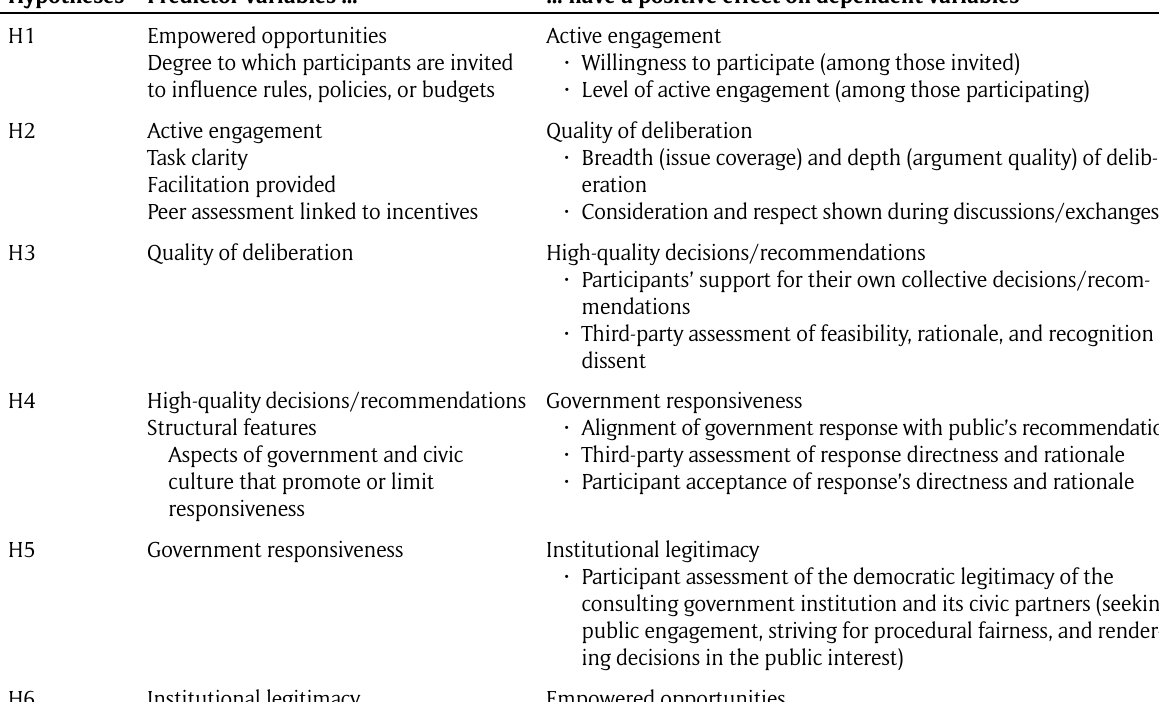
Table 1: Working hypotheses in a feedback - loop model of online public consultation. Hypotheses Predictor variables